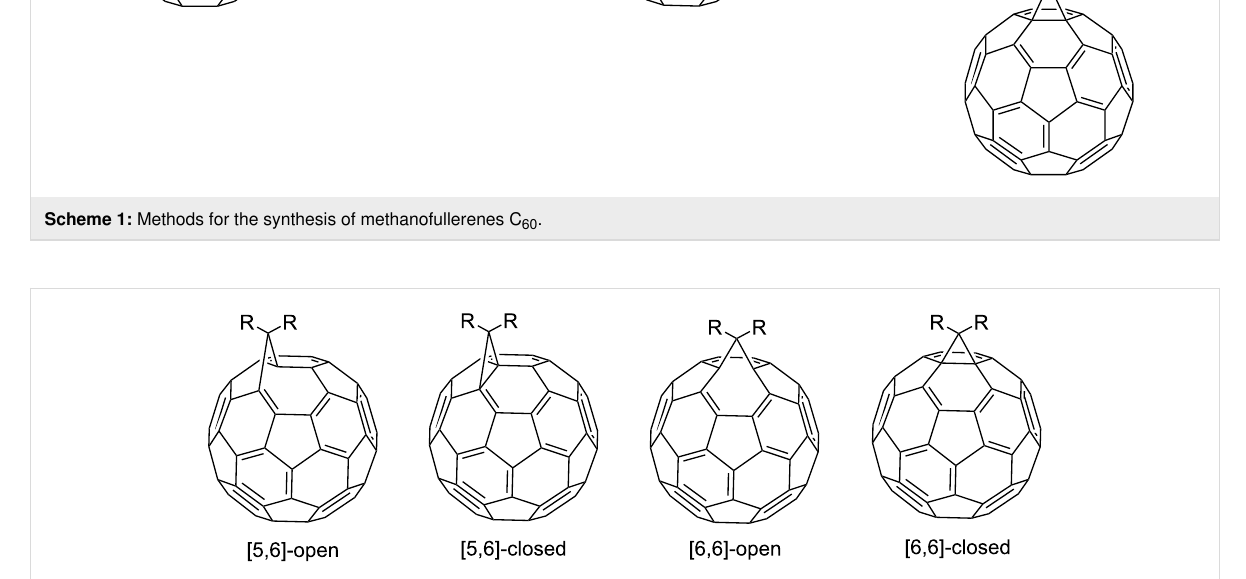
Figure 1: Four theoretically possible isomeric methanofullerenes C 60